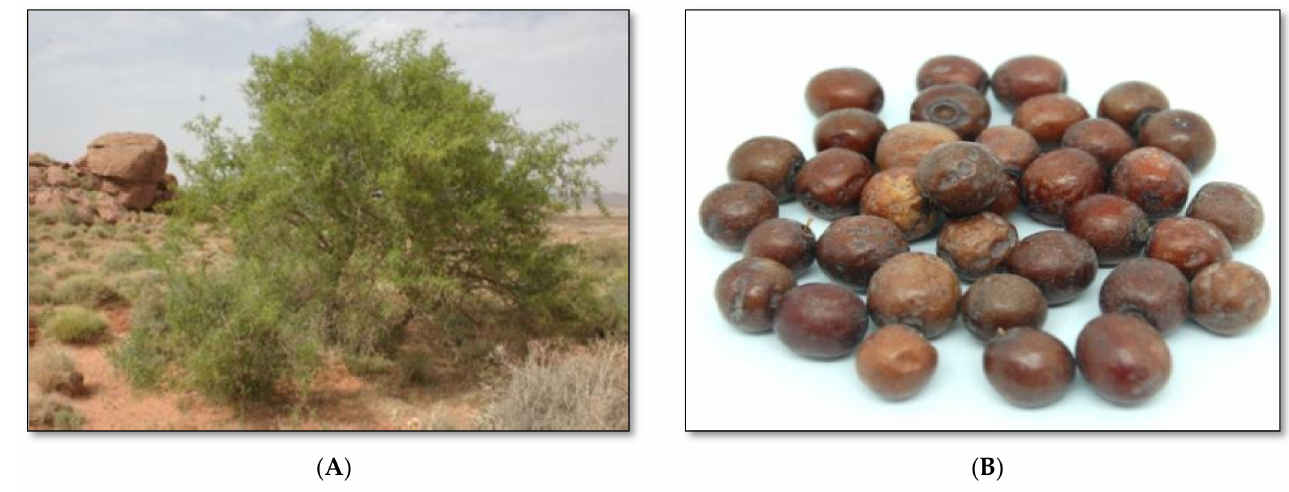
Figure 1. ( A ) Z. lotus and its habitat; ( B ) Fruits of Z. lotus